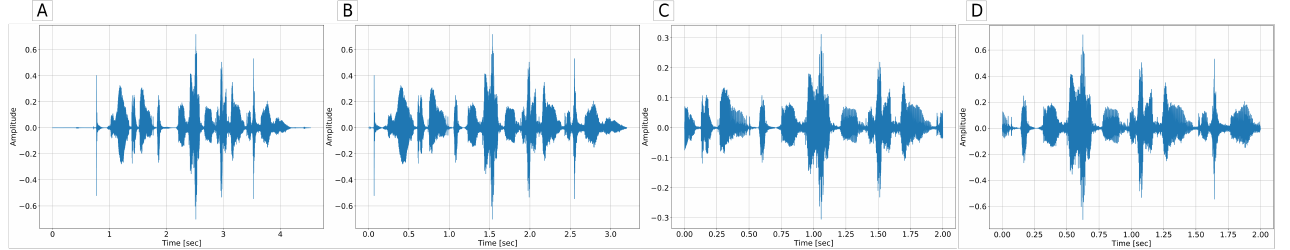
Figure 8. Different waveform preprocessor stages illustarted. ( A ) unprocessed waveform, ( B ) waveform after VAD, ( C ) waveform after random cropping 2 s of the VAD output, ( D ) applying dBFS normalization to the level of − 30 dB to the output of stage